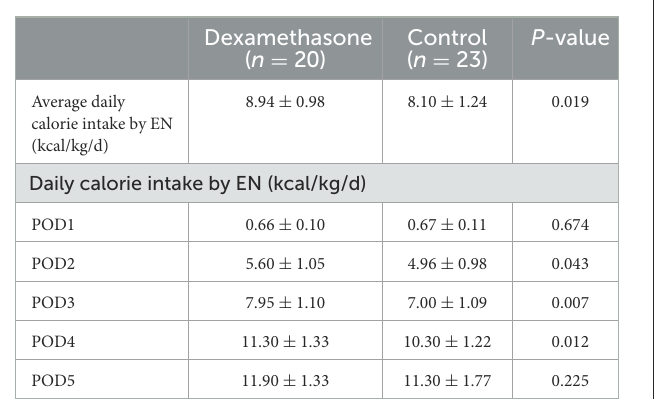
TABLE 4 Enteral nutrition caloric intake in the female patient group.